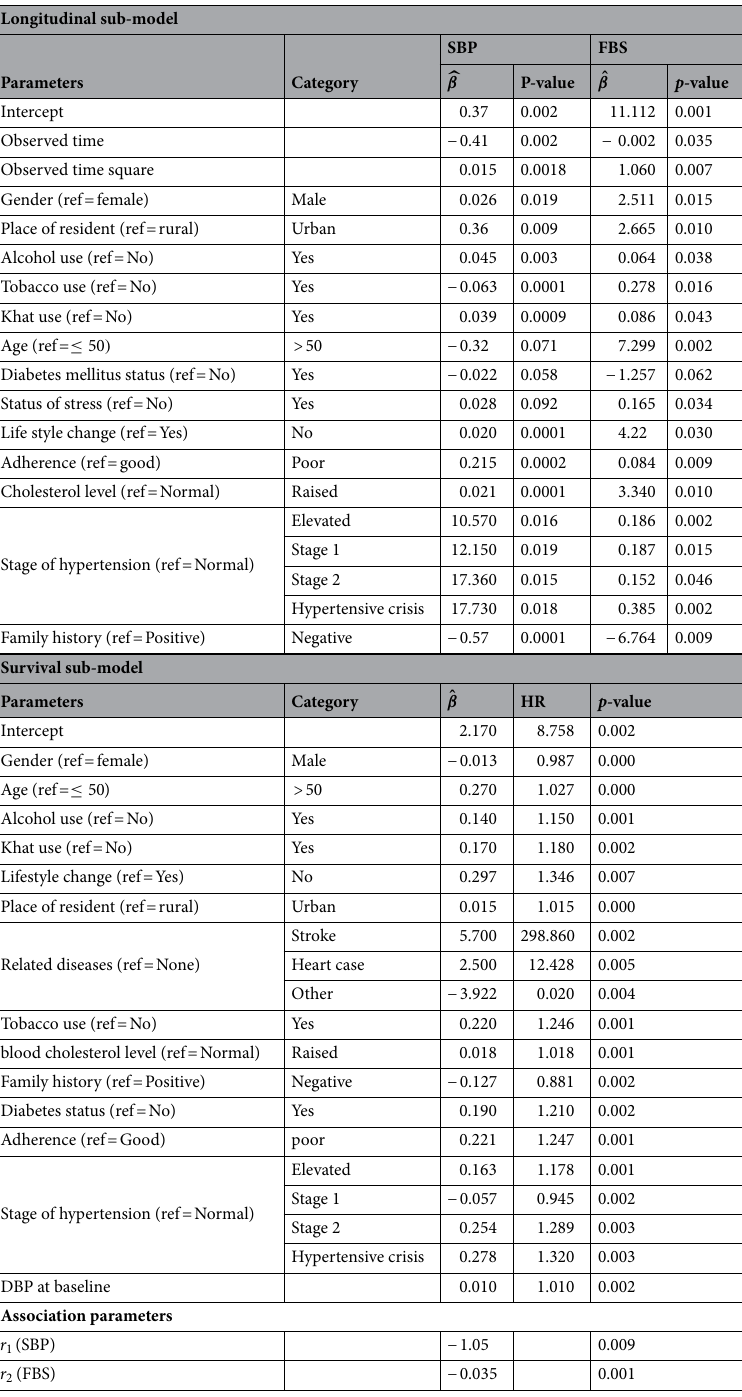
Table 5. Joint model analysis of FBS, SBP and the time to death of hypertension patient’s data at